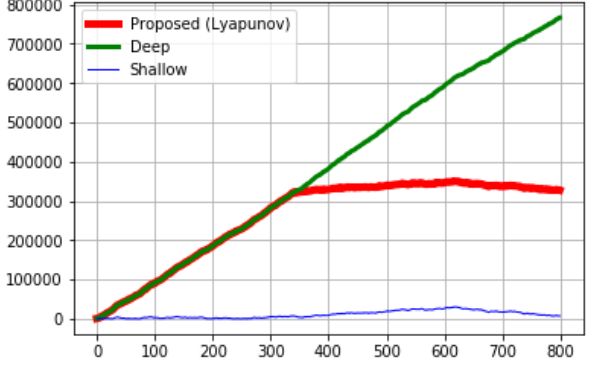
Figure 3. Performance Evaluation: Queueing-Backlog ( x -axis and y -axis stand for unit time (unit: msec) and queue-backlog (unit: bits),